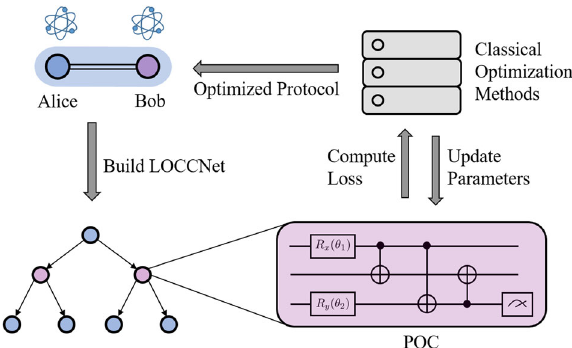
Fig. 1 Illustration of the procedure for optimizing an LOCC protocol with LOCCNet. For simplicity, only two parties are involved in this work fl ow, namely Alice and Bob. The tree presented here corresponds to a speci fi c two-round LOCC protocol. Such a tree can be customized with LOCCNet. With each node (Local Operation) encoded as a PQC and arrows between nodes referring to classical communication, one can de fi ne a loss function to guide the training process depending on the task. The tree branch diverges indicating different possible measurement outcomes. Finally, one can adopt optimization methods to iteratively update the parameters in each local operation and hence obtain the optimized LOCC